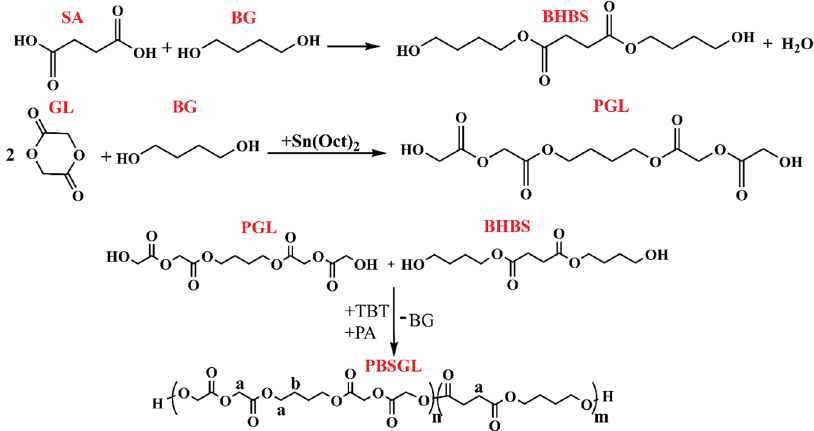
Figure 11. Reactions during two-step synthesis of PBSGL co-polyesters: direct esterification of SA and BG for synthesis of BHBS; ring opening polymerization of GL and BG in the presence of Sn(Oct) 2 as a catalyst to produce short chain PGL; condensation reaction between PGL and BHBS in the presence of TBT (catalyst) and PA (thermal stabilizer) for the synthesis of PBSGL